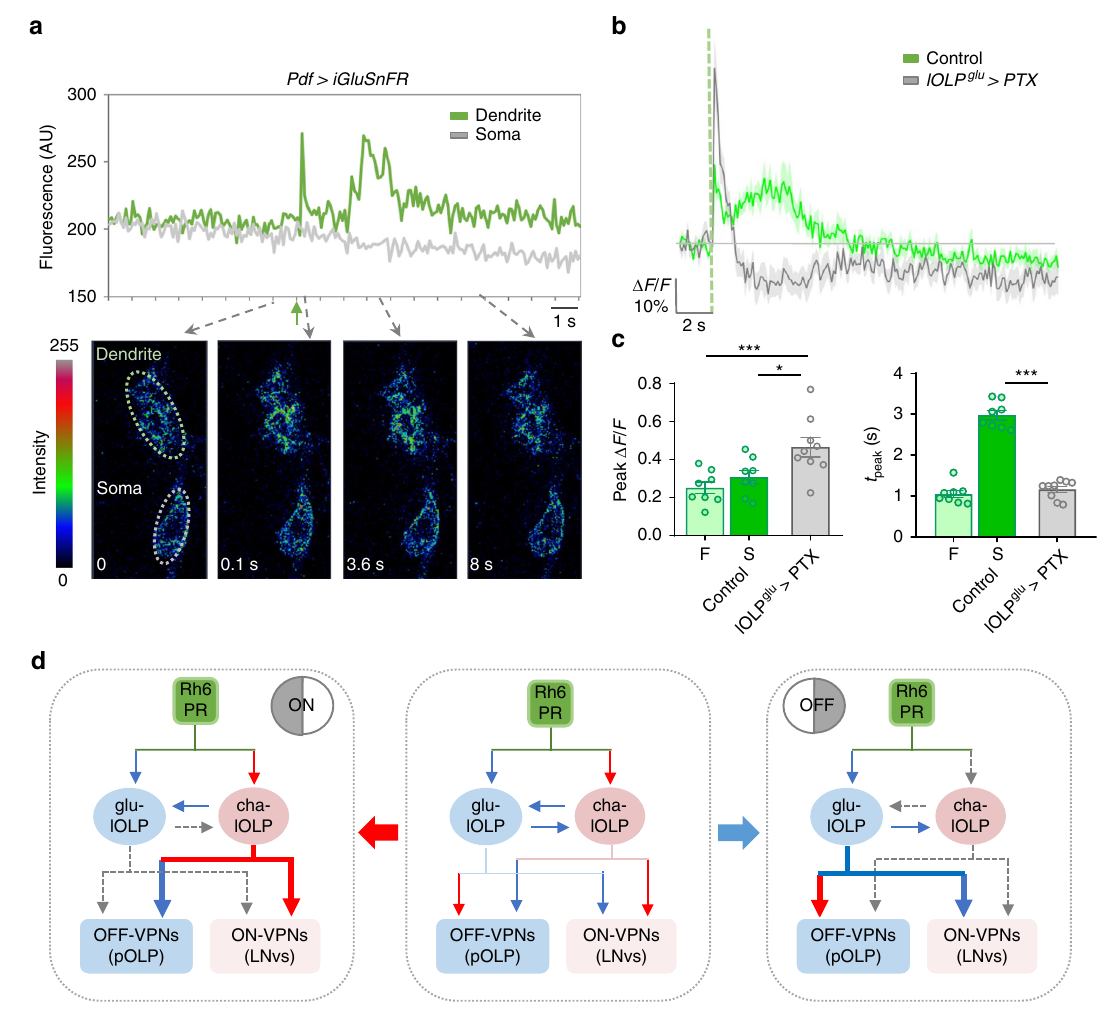
Fig. 7 Light elicits delayed glutamate release from glu-lOLP. a Top: A representative raw trace of the light-induced glutamate transient generated by iGluSnFR recording on LNv dendrites. Bottom: representative frames from the same recording show increased iGluSnFR signals in the LNvs ’ dendritic region but not the soma. The green arrow indicates the light pulse. b , c A light pulse (green dashed line) induces a biphasic release of glutamate onto the LNv dendrites. PTX expression in glu-lOLP eliminates the slow phase of the glutamate transient. b Average traces of the glutamate transients. c Quanti fi cation of changed intensity ( Δ F / F ) in iGluSnFR signals on LNv dendrites. The fast phase (F) and slow phase (S) have different latencies and similar amplitudes. PTX expression in glu-lOLP eliminates the slow phase and generates one fast transient with an increased amplitude compared to the controls. Control: n = 8; lOLP glu > PTX: n = 9. Peak value: ANOVA: p = 0.0033, F = 7.473, df = 22; F/lOLP glu > PTX: p = 0.0034; S/lOLP glu > PTX: p = 0.0318. Peak time: p < 0.0001, F = 134.6, df = 22; F/lOLP glu > PTX: p = 0.6569; S/lOLP glu > PTX: p < 0.0001. Shaded areas on traces and error bars on quanti fi cations represent SEM. Statistical signi fi cance determined by one-way ANOVA with post hoc Tukey ’ s multiple comparison ’ s test. * p < 0.05, *** p < 0.001. d A proposed model illustrating the emergence of ON and OFF selectivity in the larval visual circuit. Middle: lOLPs detect and transmit the ON and OFF signals in the larval visual circuit. Light induces acetylcholine release from Rh6-PRs, which activates cha-OLP and inhibits glu-lOLP through differentially expressed AChRs. During an ON response (left panel), the cholinergic transmission is dominant, activating ON-VPNs and suppressing OFF-VPNs. During an OFF response (right panel), glu-lOLP activates OFF-VPNs and suppresses ON-VPNs. The synaptic interactions are labeled blue for inhibitory and red